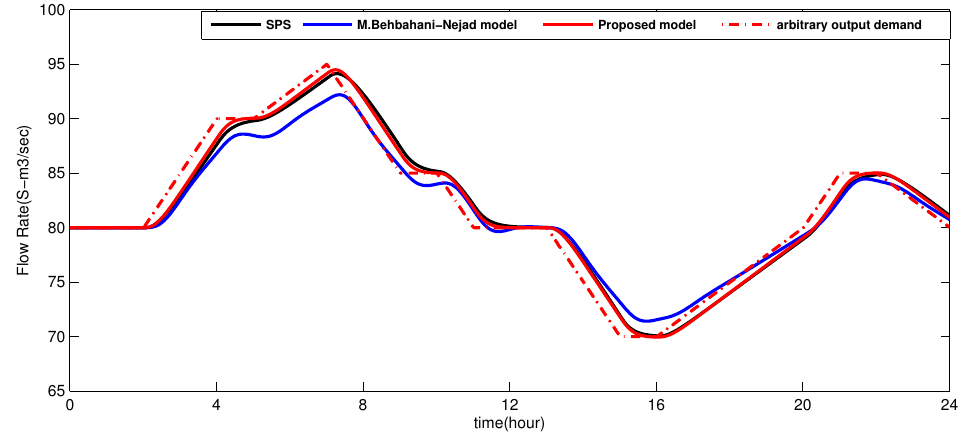
Figure 6. Inlet flow rate changes with time.